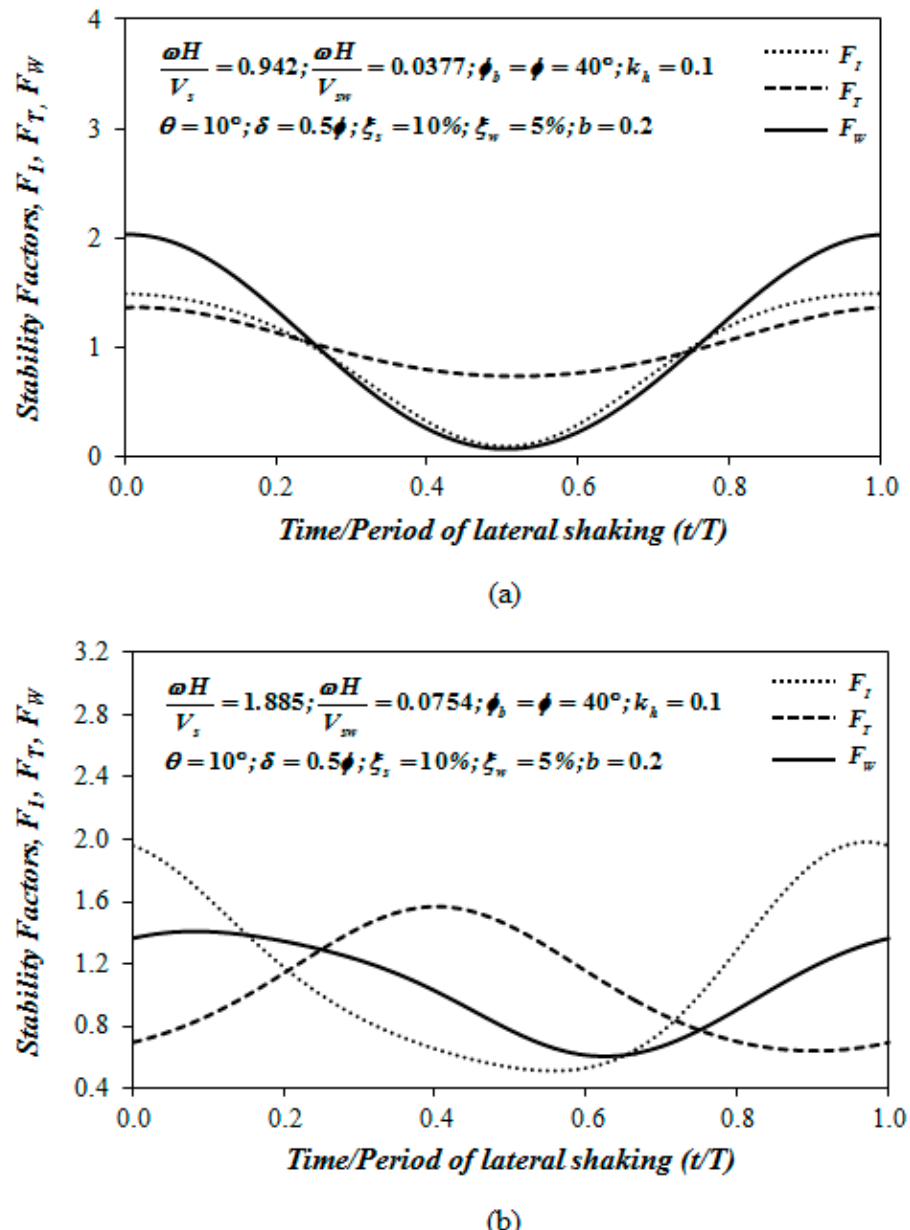
Figure 2. ( a ) Variation of stability factors F I , F T , and F W with time/Period of lateral shaking ( t/T ) for ( ω H/V s < π /2) and ( b ) Variation of stability factors F I , F T , and F W with time/Period of lateral shaking ( t/T ) for ( ω H/V s > π /2).